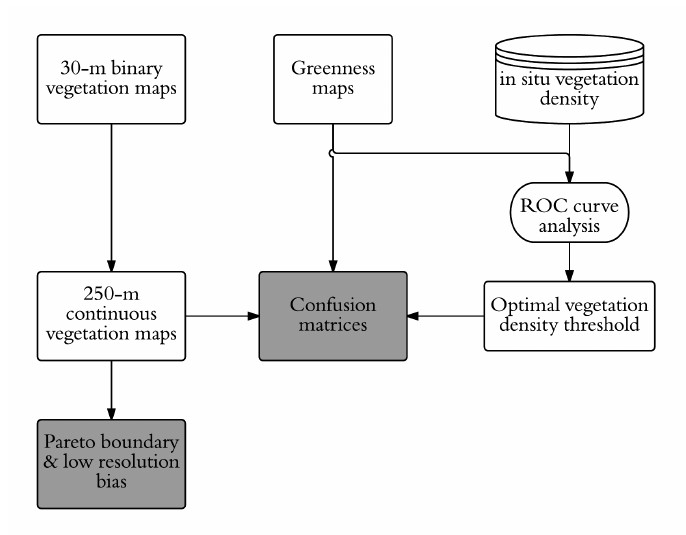
Figure 4. Flowchart of the accuracy assessment. The analysis of the ROC curve built with the greenness maps and in situ observation allowed defining an optimal vegetation threshold for detection. This threshold was then applied to continuous vegetation reference maps degraded at 250 m to derive confusion matrices for the greenness maps. The Pareto boundary was also computed thanks to the continuous vegetation reference maps, which permitted identifying the part of the error solely due to the